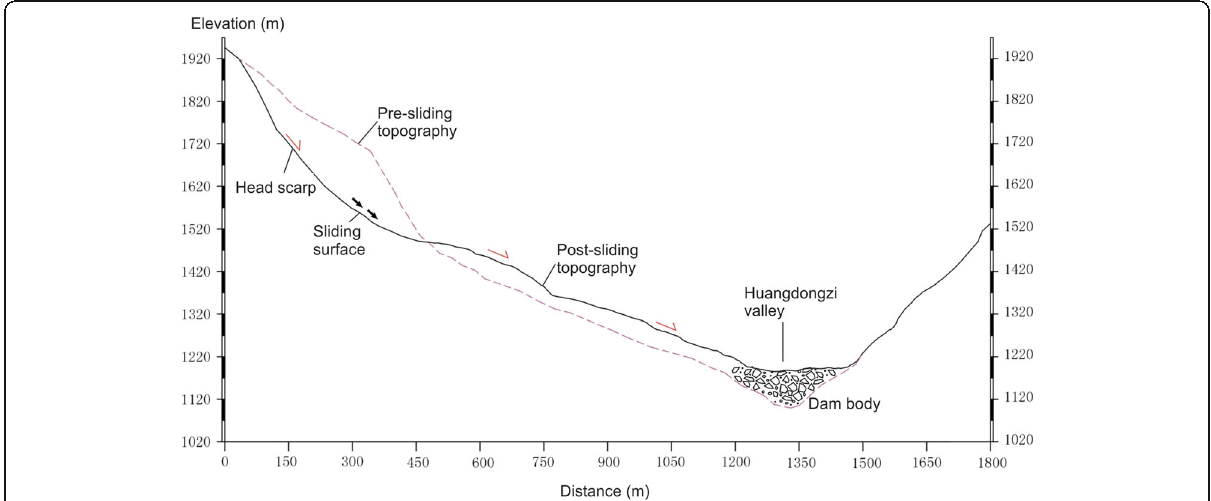
Fig. 6 Typical profile of the Laoyingyan landslide